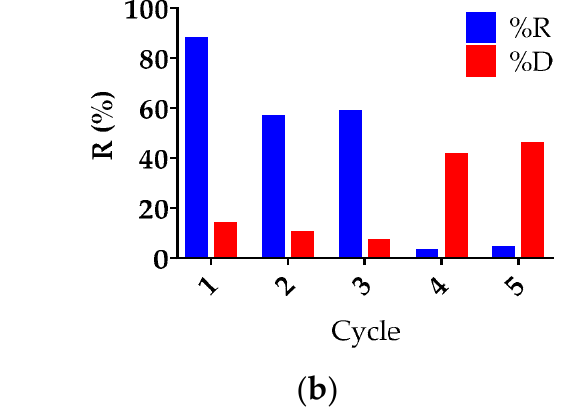
Figure 10. ( a ) Effect of MO concentration on the adsorption capacity of Hy01 at pH 7.64 with different concentrations of MO (mg L − 1 ). ( b ) Effect of adsorption–desorption cycles on adsorption capacity (pH = 7.64; initial concentration: 2000 mg/L; and 50 mg adsorbent).